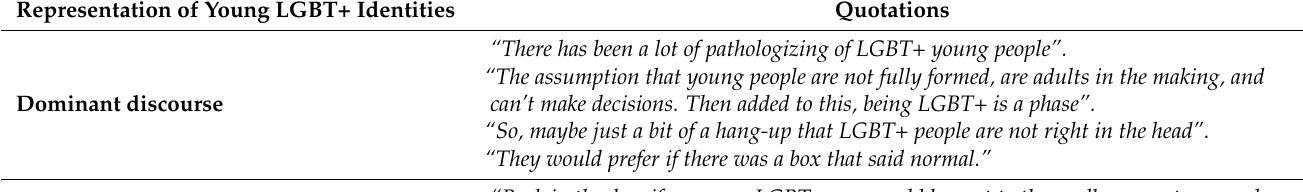
Table 3. Youth co-authors reflections on the dominant discourse and representations of young LGBT+